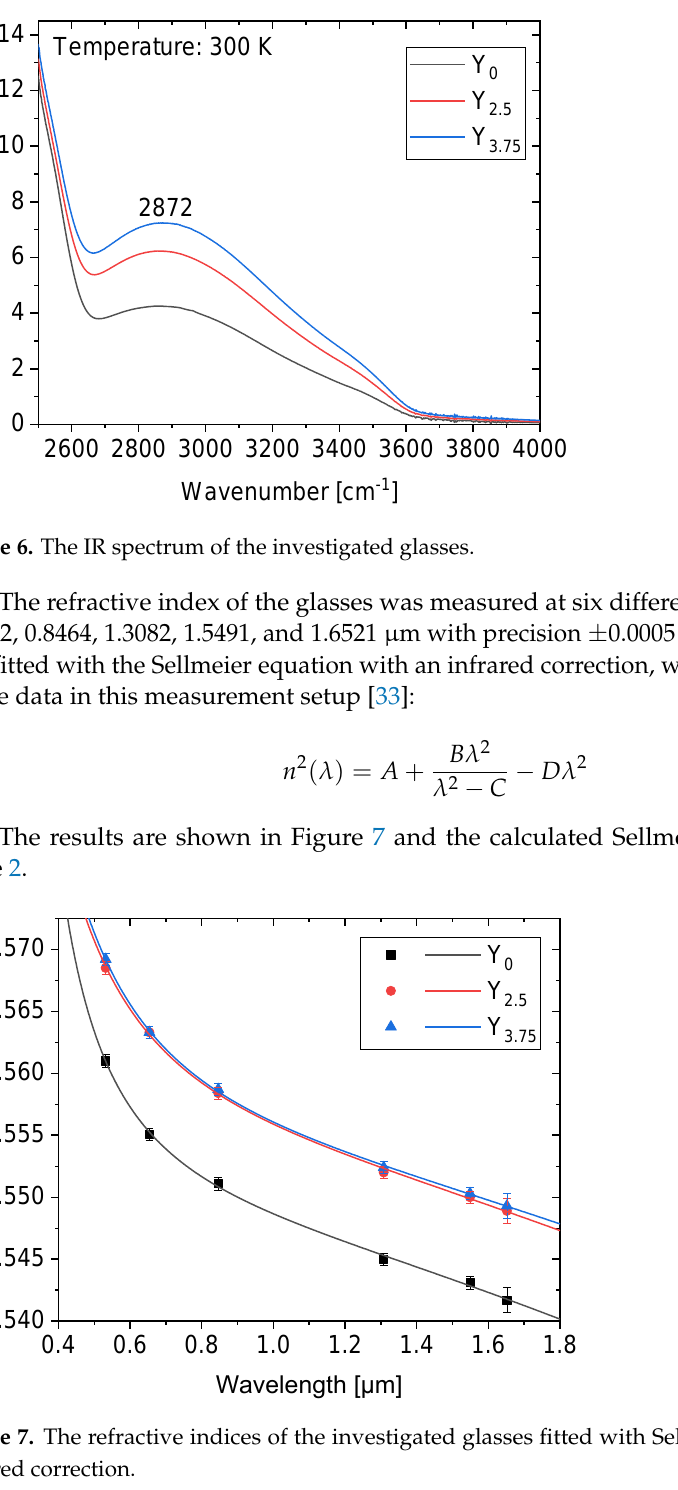
Figure 7. The refractive indices of the investigated glasses fitted with Sellmeier equation with an infrared correction. The refractive indices decreases with increasing wavelength and increases with the addition of Y 2 O 3 as expected due to the heavy Y compared to the other elements in the glass. The measured values are slightly higher (in the 10 − 2 range) than the average of